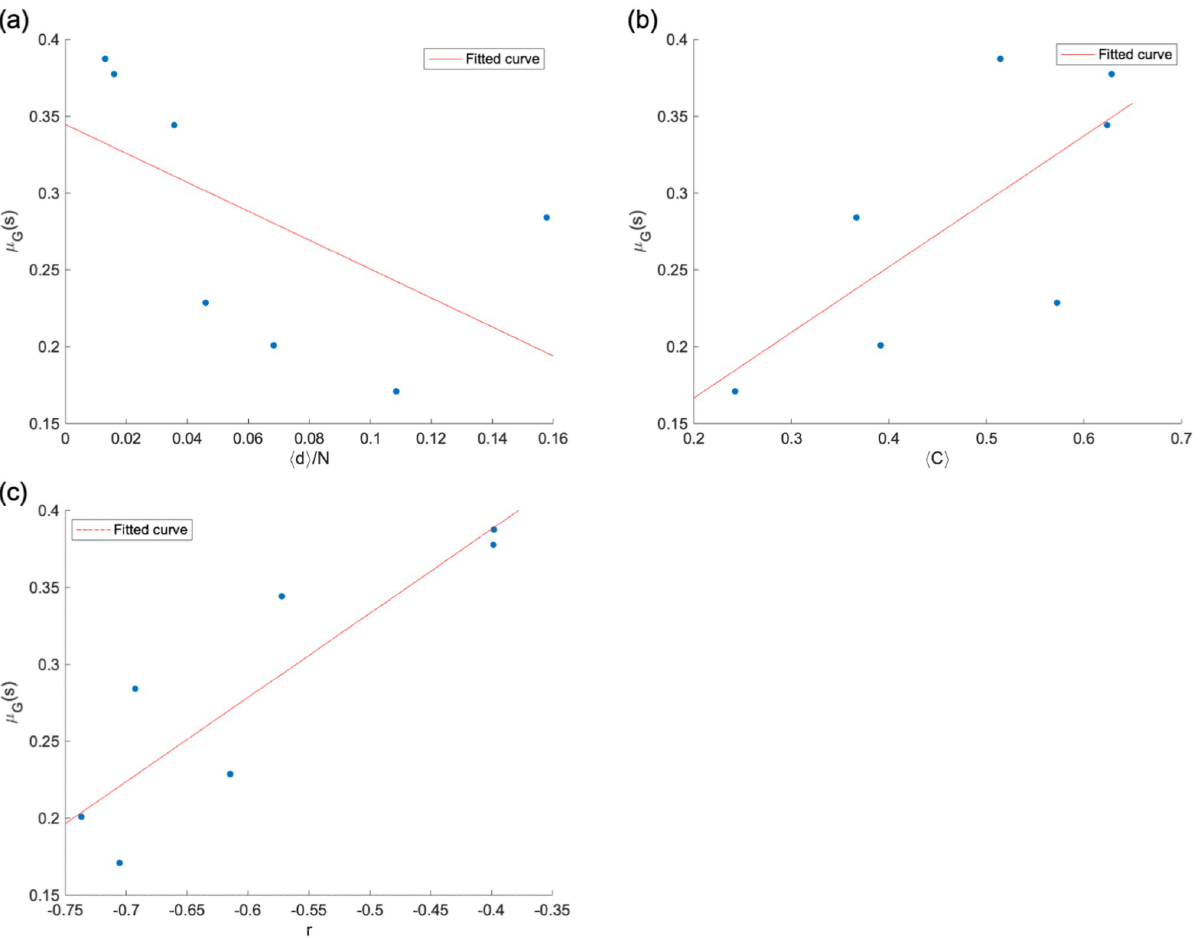
Fig 10. Relationship between geometric mean of strength μ ( s ) and network features of each community. (a) μ G normalized by the number of nodes h d i / N . (b) μ G ( s ) vs. the average clustering coefficient h C i . (c) μ G ( s ) vs. assortativity r . There is a linear relationship between each network feature and μ ( s ), indicating that there is a relationship between network structure and medical cooperation. G